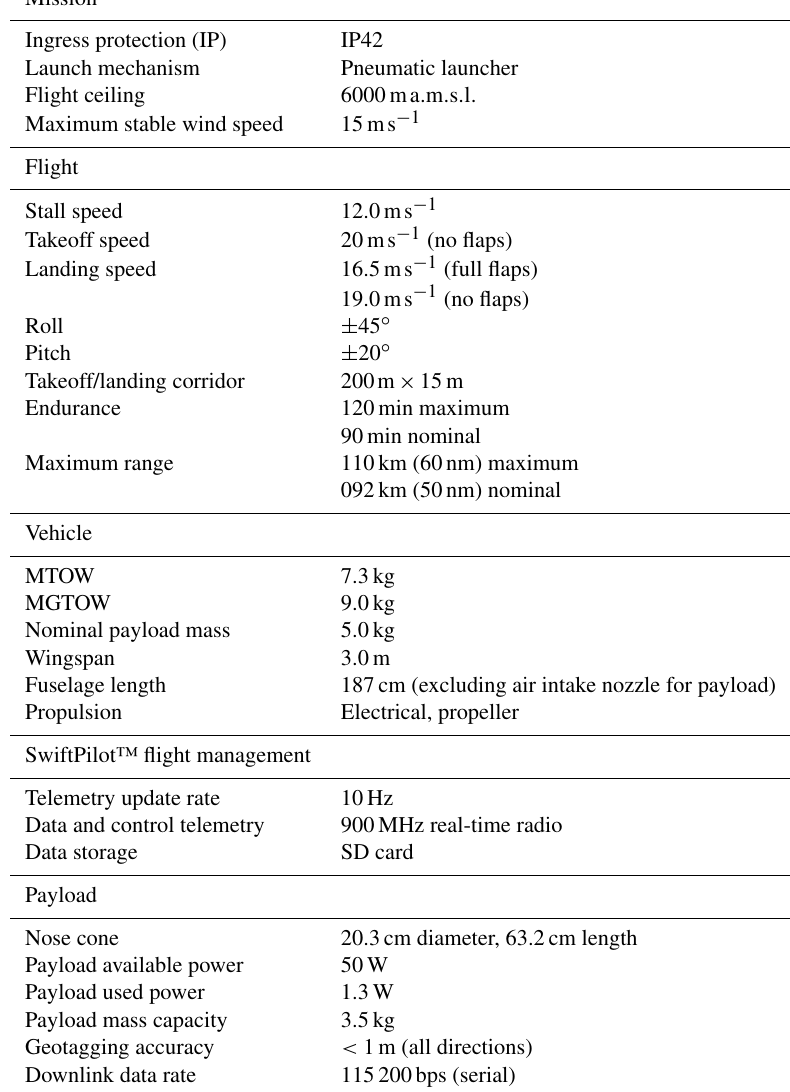
Table C1. Black Swift Technologies S2™